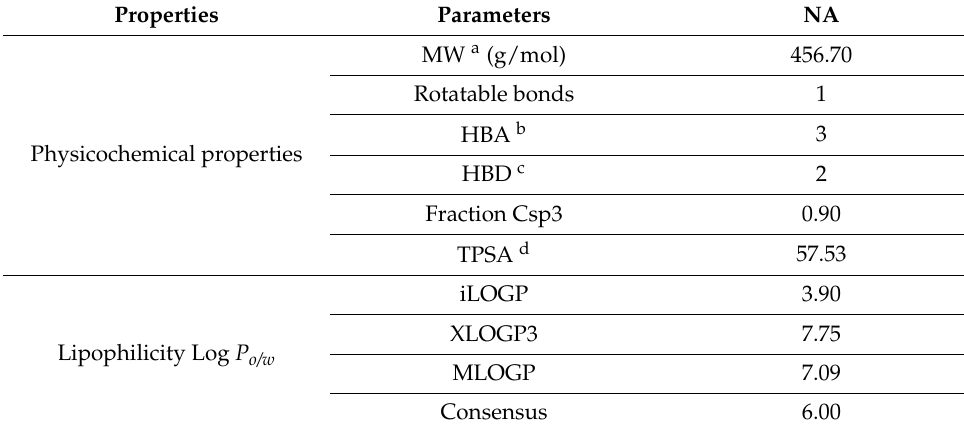
Table 1. Predicted physicochemical parameters and lipophilicity properties of